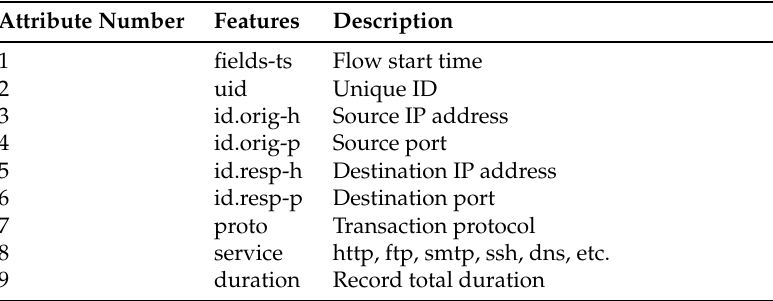
Table 5. IoT-23 dataset features’ list with